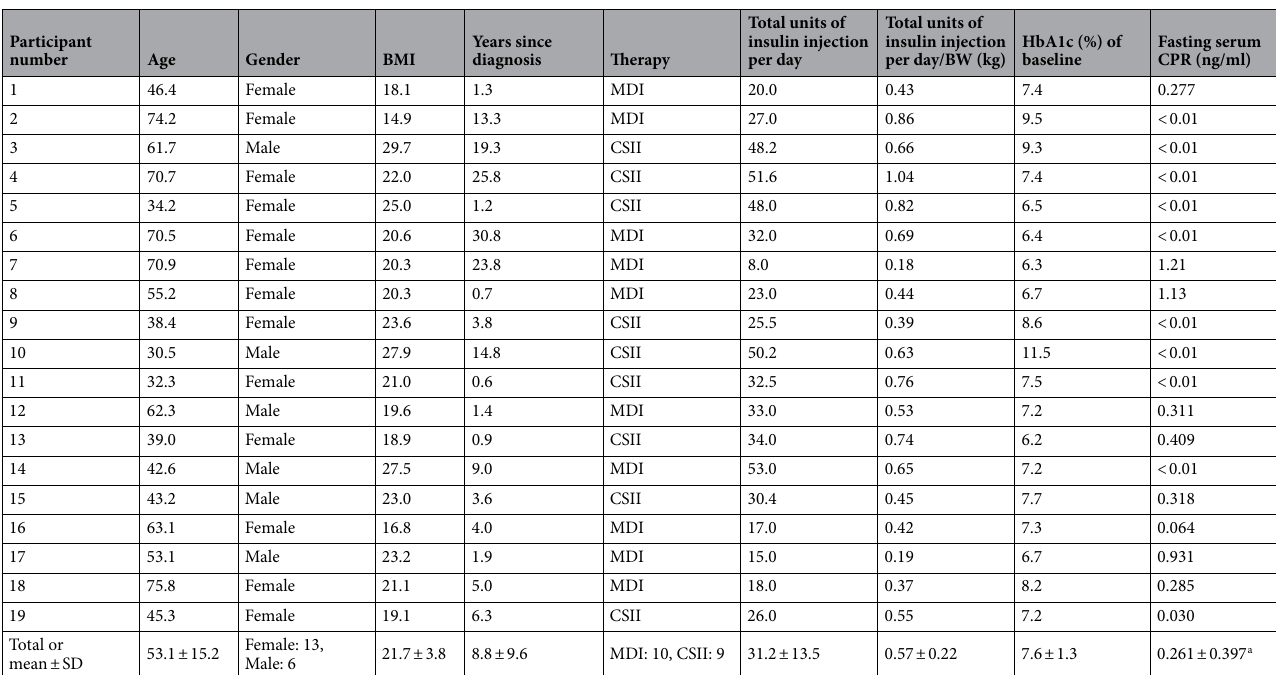
Table 2. Patient characteristics. BMI body mass index, BW body weight, CPR C-peptide immunoreactivity, CSII continuous subcutaneous insulin infusion, MDI multiple dose insulin injection. a The values of serum CPR “ < 0.01” were considered as 0 and calculated. Fasting CPR was measured on at least three different dates and the value on the day closest to the baseline date were